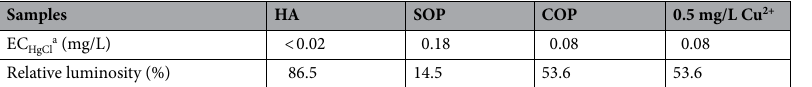
Table 4. Ecotoxicity analysis of catalysts. a EC HgCl : Equivalent concentration of mercuric chloride.